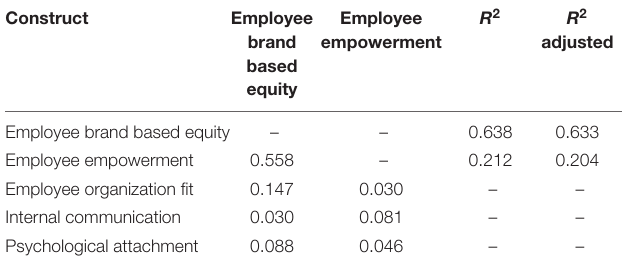
TABLE 5 | F 2 , R 2 , and adjusted R 2